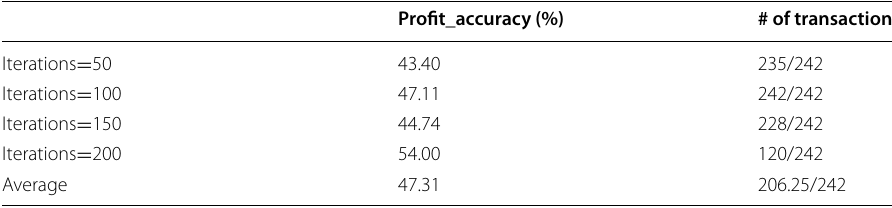
Table 12 ME_LSTM model: five‑days‑ahead result